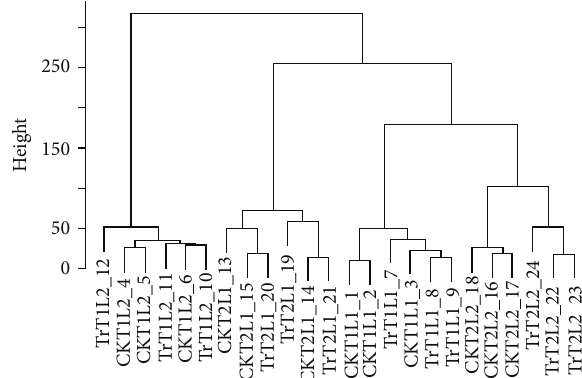
Figure 2: Cluster dendrogram illustrating the relationships among the leaf tissues harvested at different time points (T1/T2), leaf position (L1/L2) of control plants (CK), and plants treated with gelatin capsule (Tr), which were calculated based on the expression data of the 620 DEGs.